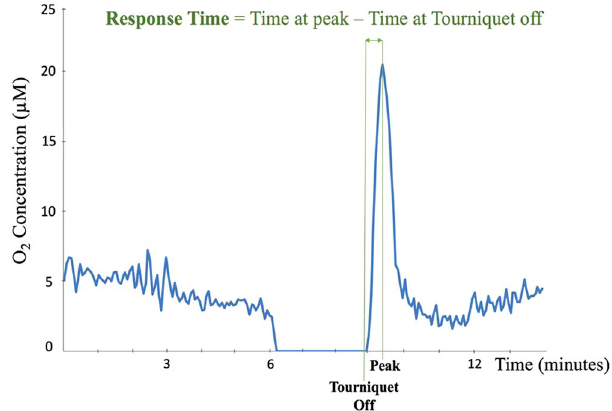
Figure 6. Response time demonstrates the amount of time a technique takes to detect the peak occurrence following tourniquet release.